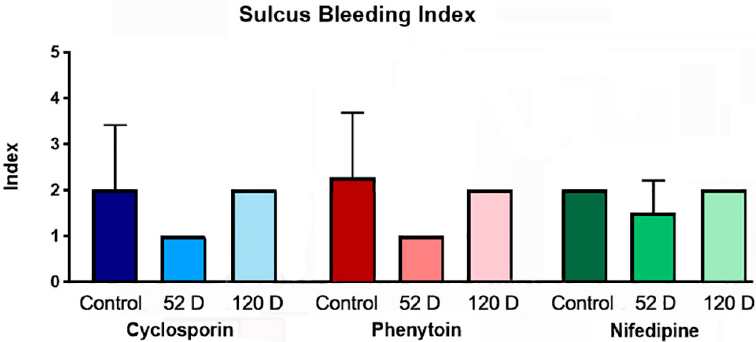
Figure 1- Sulcus Bleeding Index at days 0 (Control), 52 and 120. Medium values of three points of measurement at the buccal side of superior canines